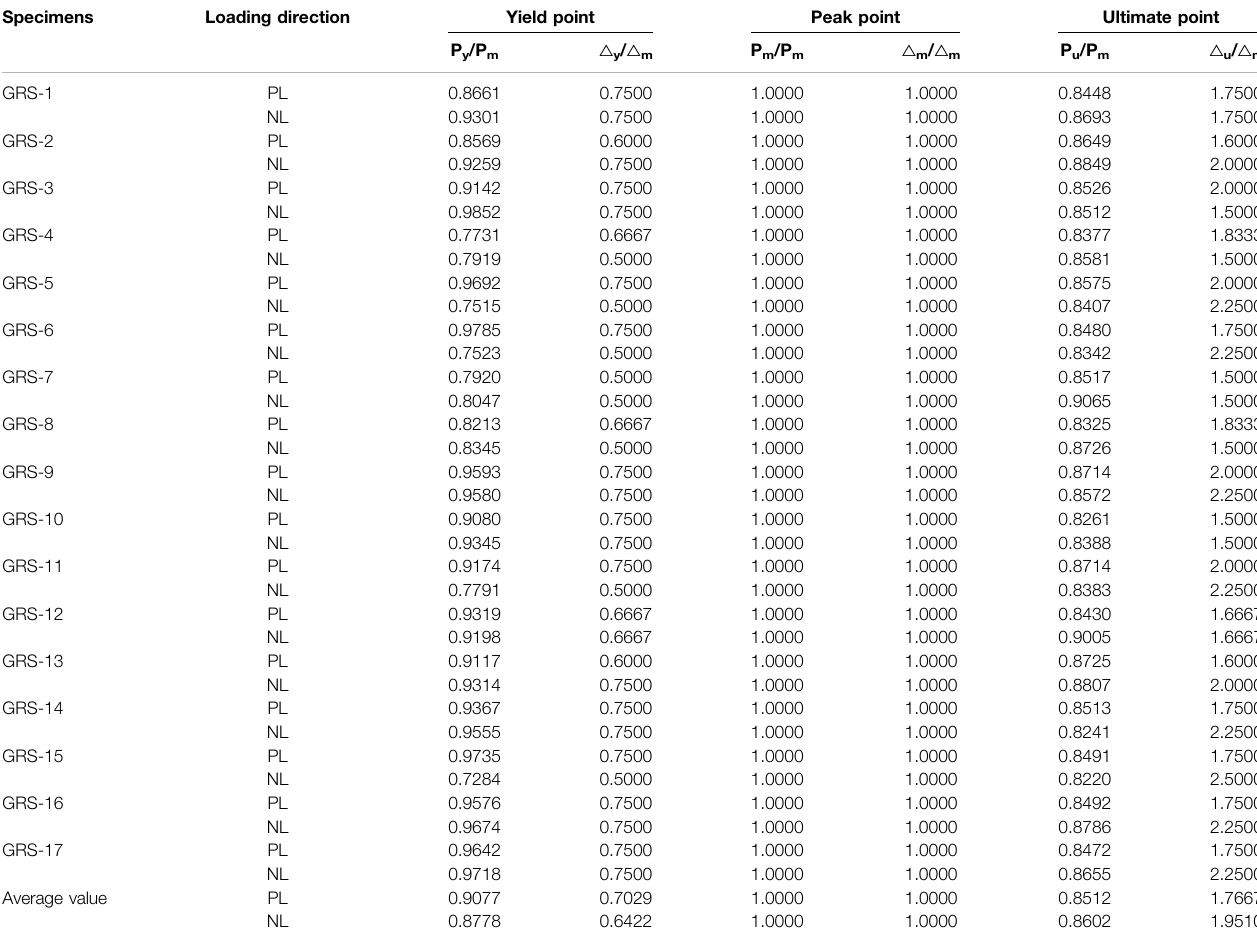
TABLE 3 | Dimensionless load and displacement of skeleton curves for specimens.